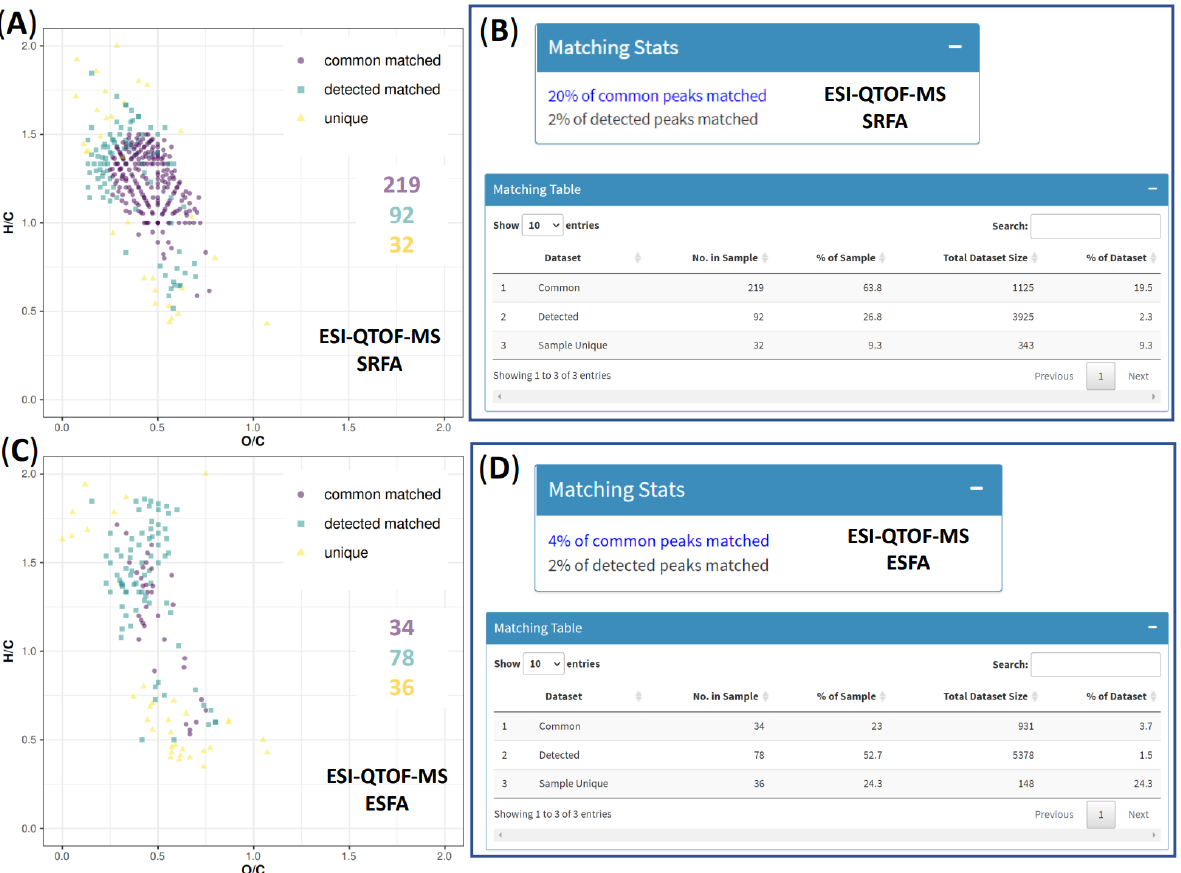
Figure 3. Van Krevelen diagrams and matching tables provided by InterLabStudy package version: 0.0.1.5 available online: https://go.warwick.ac.uk/InterLabStudy (accessed on 31 March 2022) to compare the assigned elemental compositions from the negative ESI-QTOF-MS mass spectra of Suwannee River FA (SRFA) and Elliott soil (ESFA) IHSS standards with those assigned by 17 HRMS instruments including FTICR-MS and Orbitrap-MS [46]. Van Krevelen diagrams of ( A ) SRFA and ( C ) ESFA and matching tables of SRFA ( B ) and ESFA ( D ).